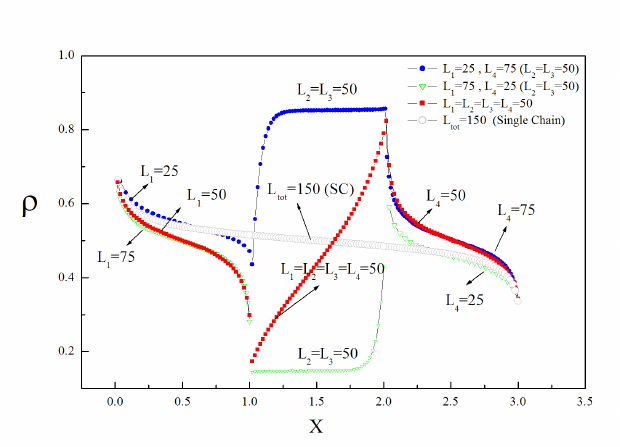
Fig. 4. Simulation results: density profiles as a function of the scaled distance x = i/L k , for the system with the ( MC, CL, MC ) phase structure, appearing when . The symmetric case with L 1 = L 2 , 3 = L 4 = 50 is shown with red squares. The change of the density profiles in the double-chain section is clearly seen: when L 1 = 25 , L 4 = 75 its shape is characteristic of the HD phase (blue circles); when L 1 = 75 and L 4 = 25 its shape is characteristic of the LD phase (green